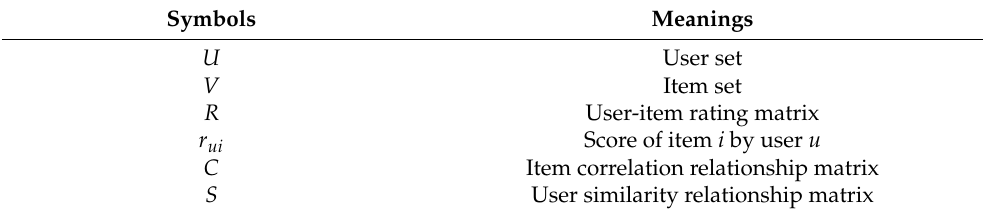
Table 2. Symbols and meanings.